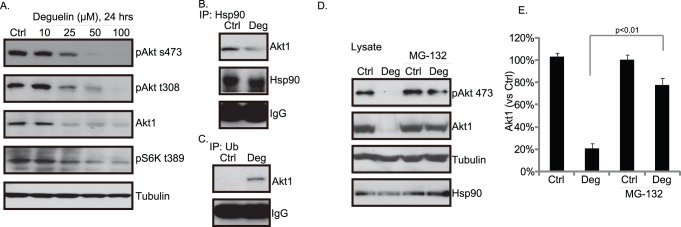
Deguelin down-regulates Akt signaling.Hep-2 cells were exposed to deguelin at indicated concentration (10, 25, 50 and 100 µM) for 24 hours, total- and phospho- levels of Akt as well as phosphorylation level of S6K were measured by Western blot using indicated antibodies (A).The association between Akt and Hsp 90 and the association between Akt and ubiquitin after deguelin treatment (Deg, 100 µM, 12 hours) were measured by immunoprecipitation (IP) assay (B-C). Effect of MG-132 (1 µM, 12 hour pretreatment) on deguelin-induced Akt degradation was shown in (D–E). The mean of at least three independent experiments performed in triplicate is shown. Statistical significance was analyzed by ANOVA.